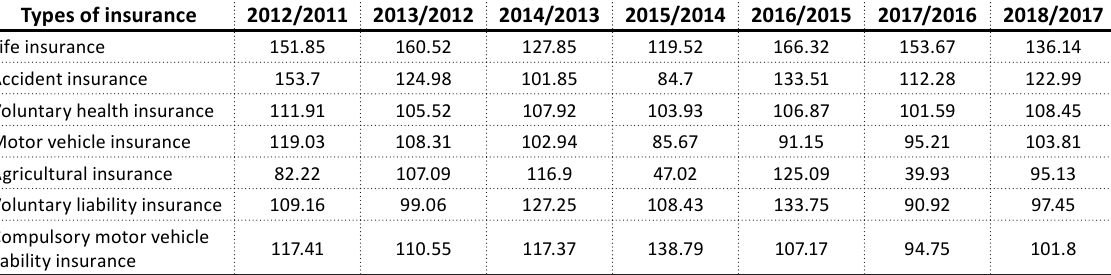
02004006008001000120014001600 Figure 1. Dynamics of the Russian insurance portfolio structure, billion rubles Table 1. The growth rate of insurance premiums for the main types of insurance, % Types of